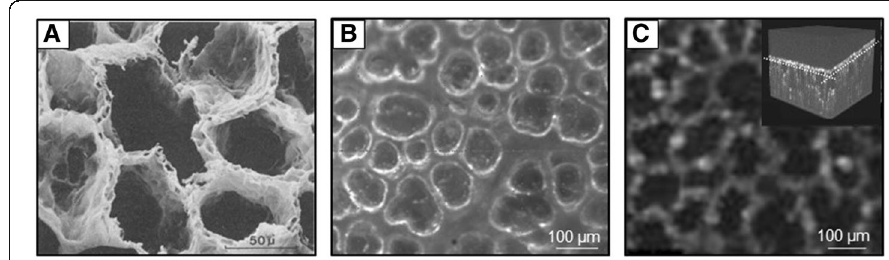
Fig. 1 a Electron micrograph of air-filled lungs fixed by vascular perfusion [40] b Representative darkfield IVM image of a healthy murine lung [59] c Representative OCT image of subpleural alveolar lung parenchyma of an isolated rabbit lung from a 3D image stack of 0.8 × 0.8 × 0.4-mm size